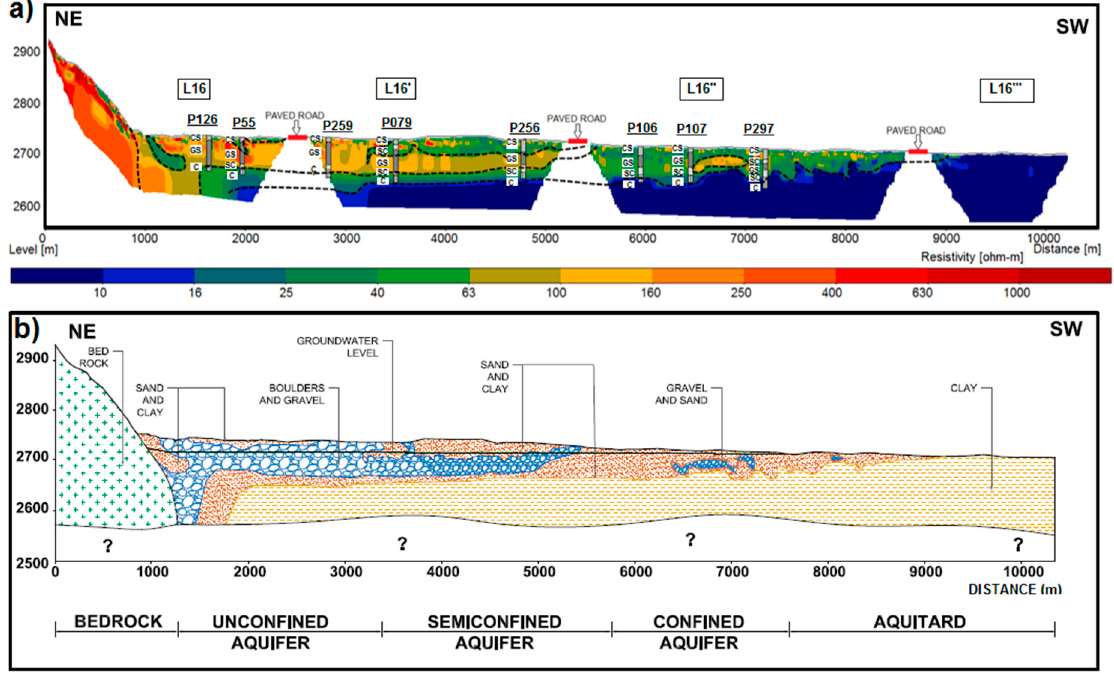
Figure 7. ( a ) Calculated resistivity along the line L16; the dashed lines are the proposed limits for the different units. ( b ) Proposed conceptual model and aquifer system in the Punata alluvial fan. The aquifer units are composed of boulders, gravel, and sand (blue pattern in Figure 7b).